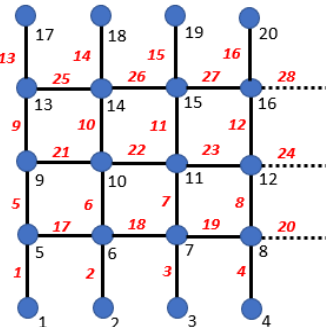
Figure 5. Pore and throat numbering in a 2D PN. The dashed lines illustrate the periodicity at the lateral boundaries.